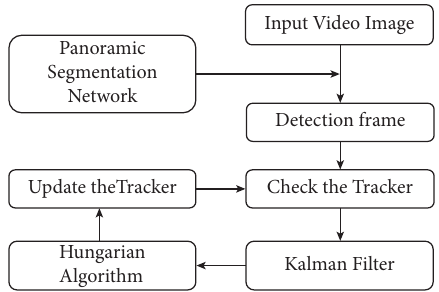
Figure 3: Tracking algorithm flowchart.